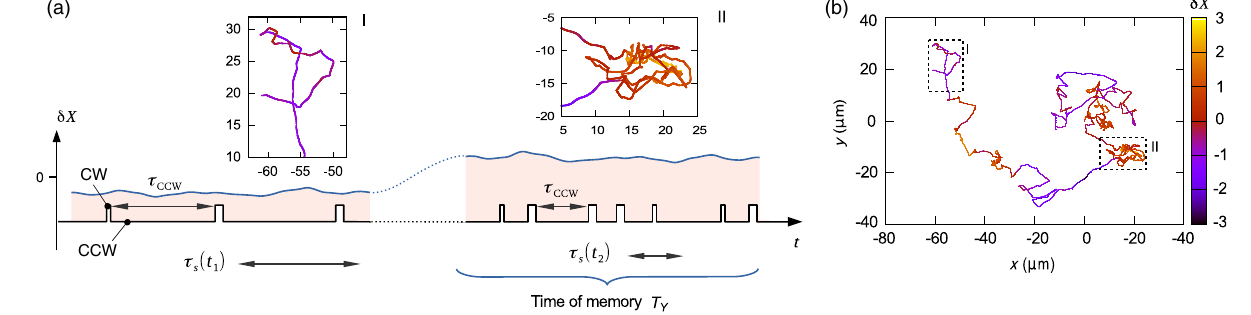
FIG. 5. Heuristic view of the behavioral variability model. (a) Timescales of the tumbling process and the CheY-P concentration governing them. The switching time τ s represents the local average of the stochastic run times τ relatively constant during the memory time T Y and evolves as a function of the normalized CheY-P concentration: δ X ¼ ð½ Y (cid:3) − ½ Y (cid:3)Þ = σ 0 Y . (b) 2D projection of the simulated 3D trajectory where the insets correspond to different levels of [ δ X ]: Inset I depicts a low CheY-P level, and inset II depicts a high CheY-P level.